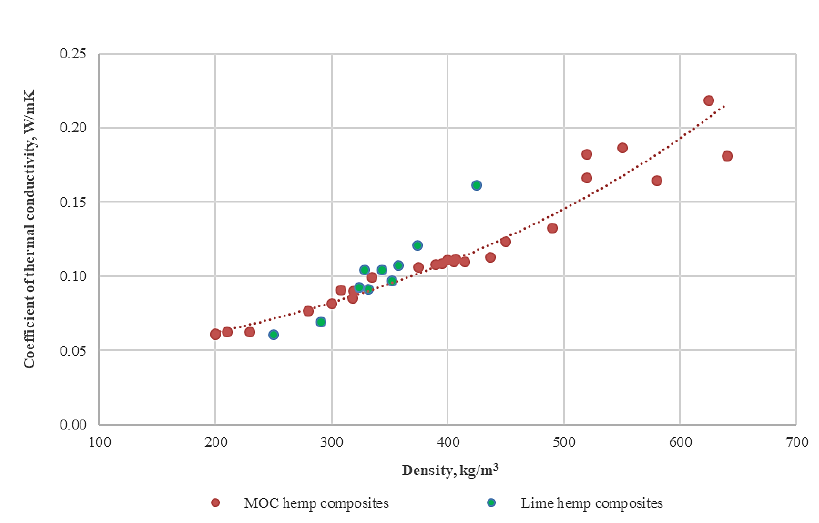
Fig. 1. Relation Dry density – coefficient of thermal